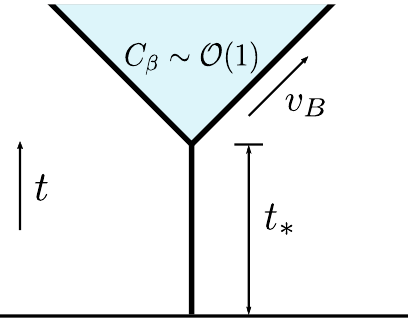
Figure 1 . Illustration of the butterfly cone. A localized perturbation at some initial time scrambles everything at that location after a scrambling time t ∗ . This effect then spreads out spatially at the butterfly velocity v B , defining the butterfly cone where C β is of order